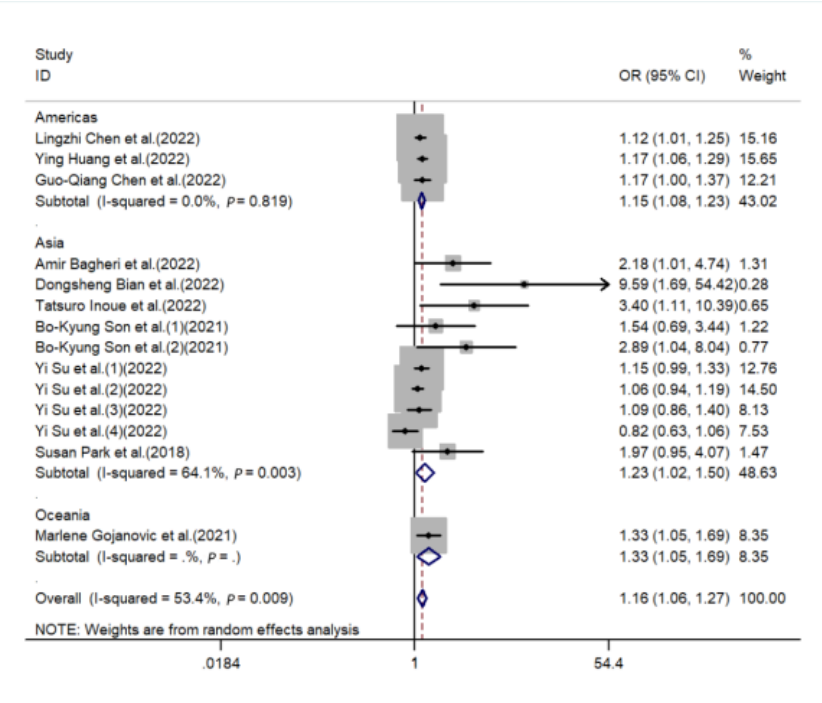
Figure 5. Forest plot for the subgroup of region [19-29] .